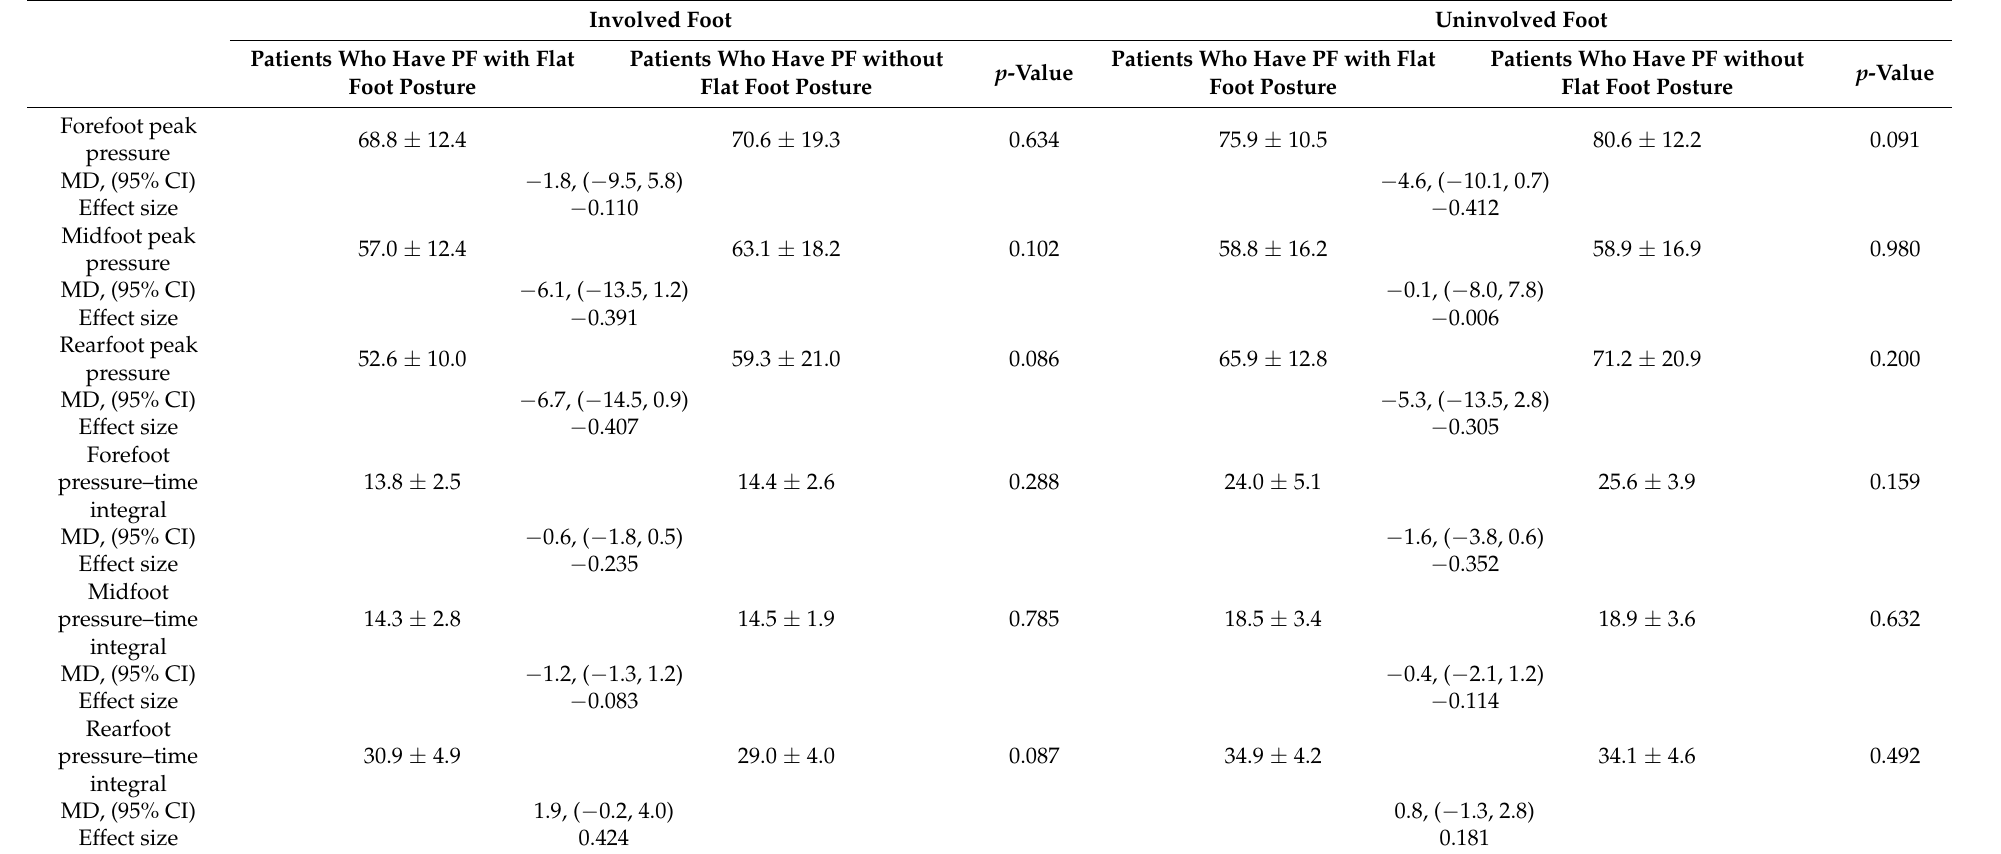
Table 3. Comparison of foot pressure in both feet of the patients who have PF with and without flat foot posture. Involved Foot Uninvolved Foot Patients Who Have PF with Flat Patients Who Have PF without Patients Who Have PF with Flat Patients Who Have PF without p -Value p Foot Posture Flat Foot Posture Foot Posture Flat Foot Posture